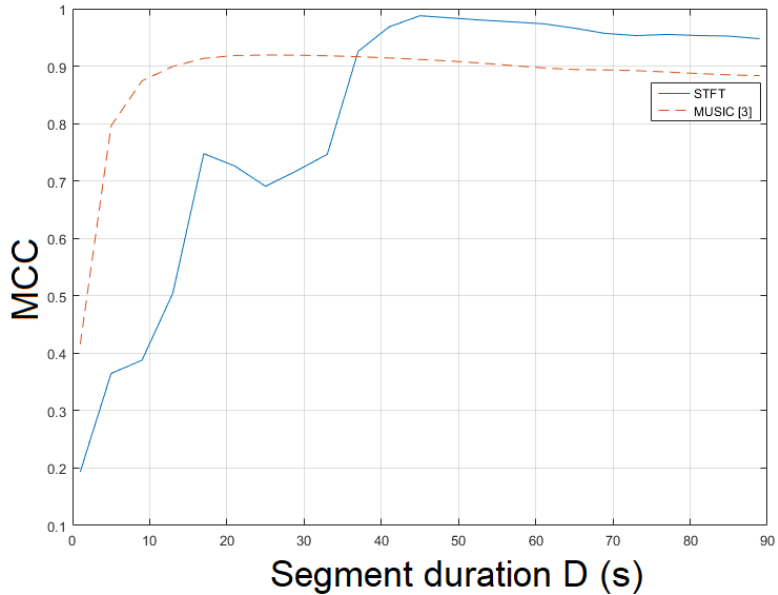
Figure 6. Maximum correlation coefficient of the proposed approach employing SLIC+STFT for various segment durations against the MUSIC [3] (mov3).